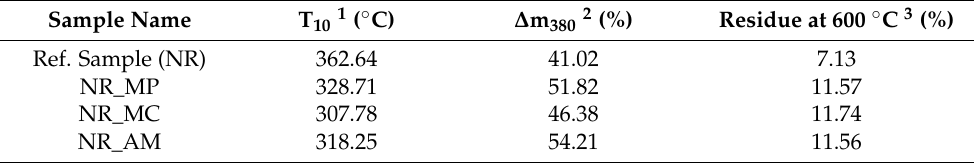
Table 3. Thermal stability of composites determined by thermogravimetric analysis.